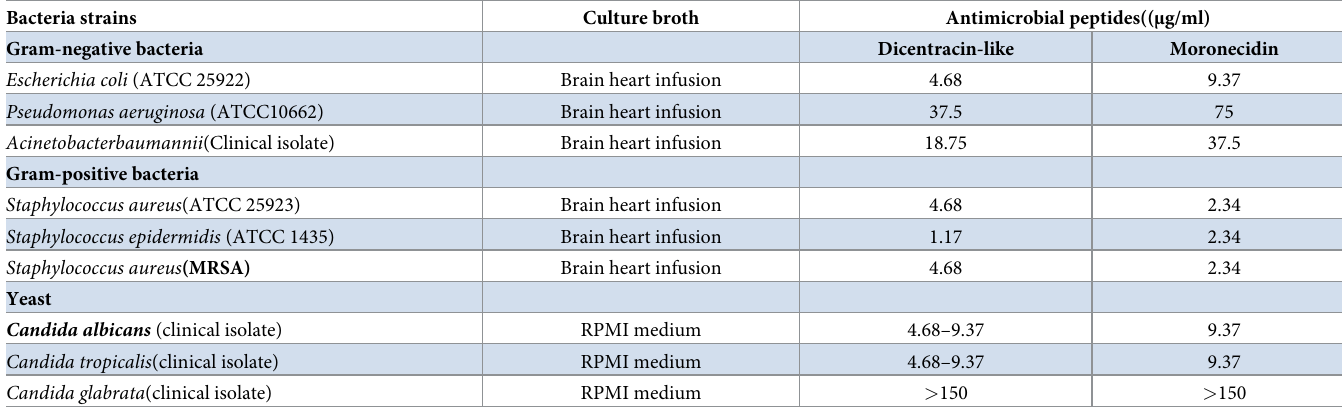
Table 2. The minimum inhibitory concentration (MIC) of dicentracin-like and moronecidin.